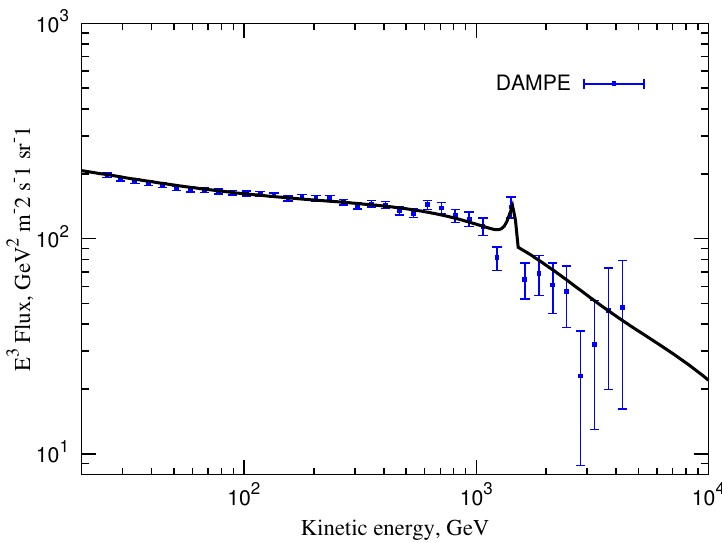
Figure 3 . Total e + + e (cid:0) (cid:13)ux of 1.5 TeV DM that annihilates into leptons with the branching